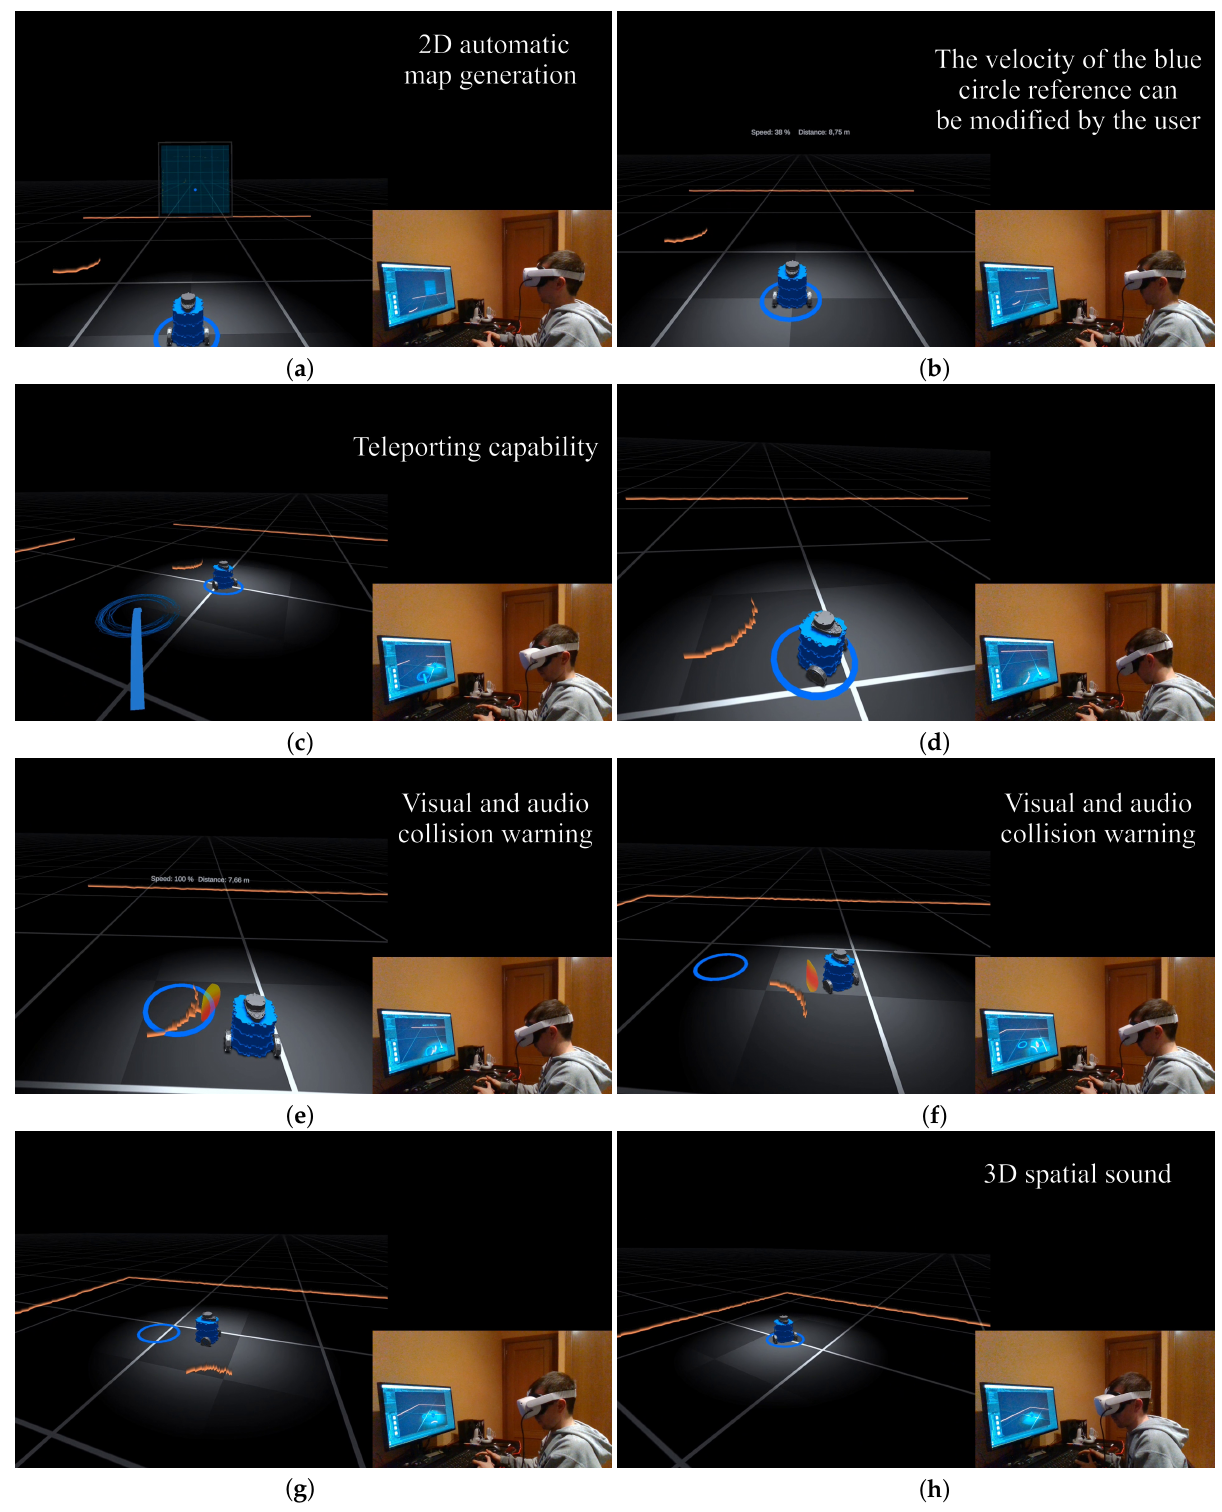
Figure 4. Case study 1: Frames of the video showing the functionalities of the proposed VR-based interface. See the video in [66]. ( a ) video: 0 min 16 s. ( b ) video: 0 min 21 s. ( c ) video: 0 min 39